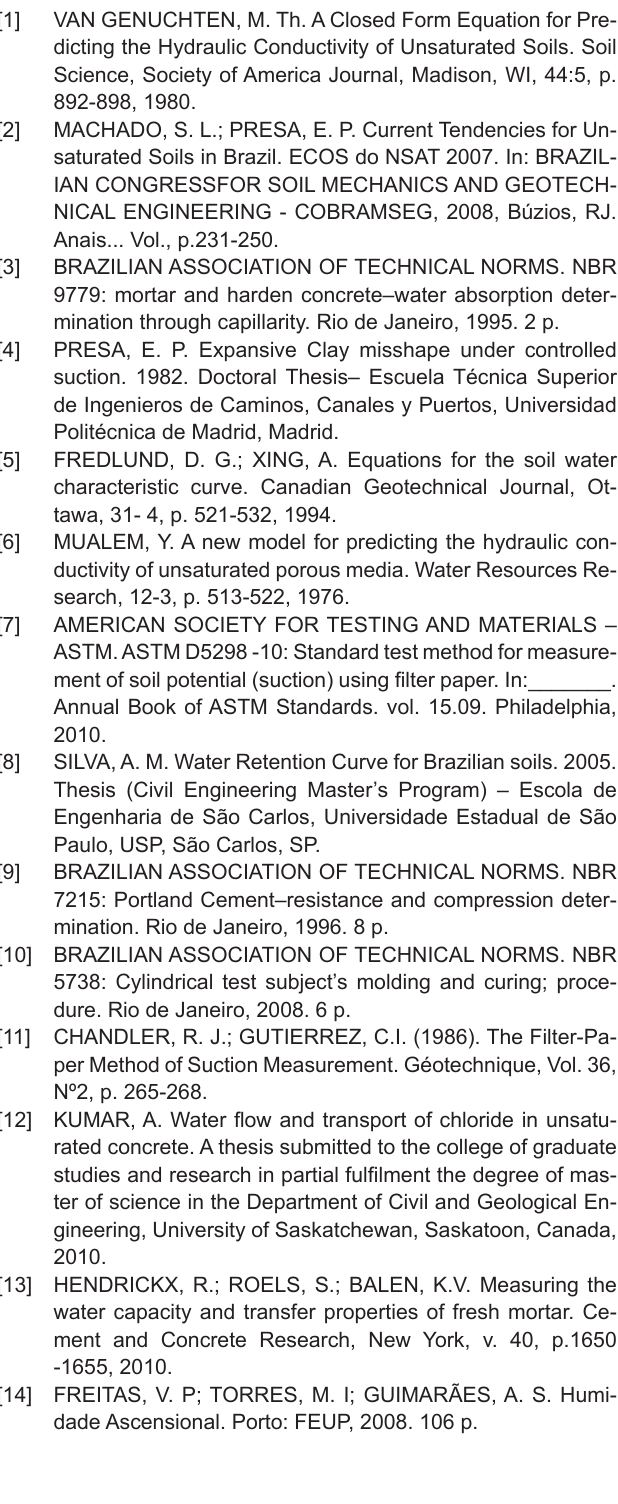
Figure 7 – Retention curve obtained from different porous materials